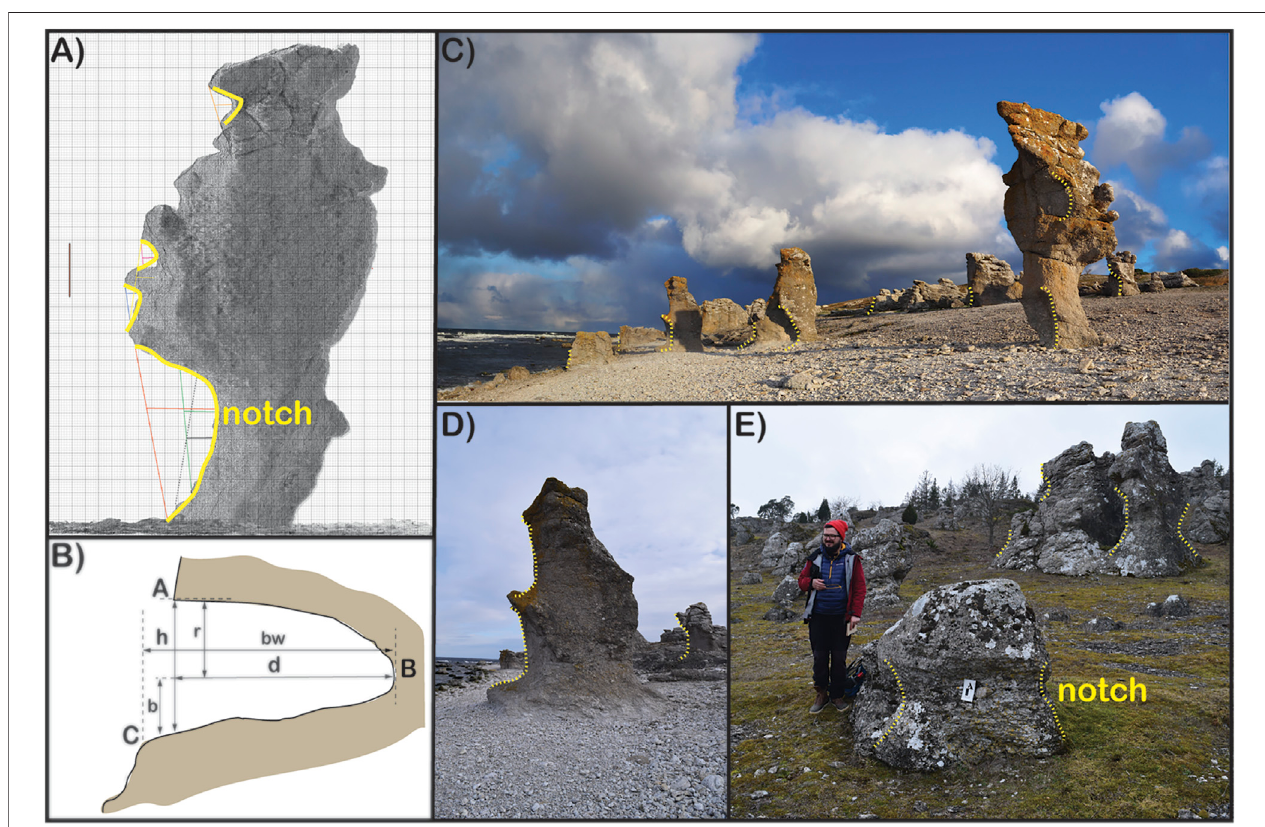
FIGURE3| Measurementsofcoastalnotchespreservedinrauksurfaces. (A) ExampleofraukscannedusingTLS; (B) parametersofnotchmeasurementsapplied inthisstudy(afterCarobene,2015). (A) notchupperlimit; (B) maximumretreatpoint; (C) thelowerlimitofthenotch;ABnotchroof;BCnotchbase; (B) theheightofpoint B over the notch fl oor; bw — base width; d — notch depth; h — notch height; r — roof height; (C,D) rauk fi eld in Langhammars with series of modern and uplifted notches persevered at different elevations; (E) rauk fi eld in Lergrav with well-preserved paleo-notches.